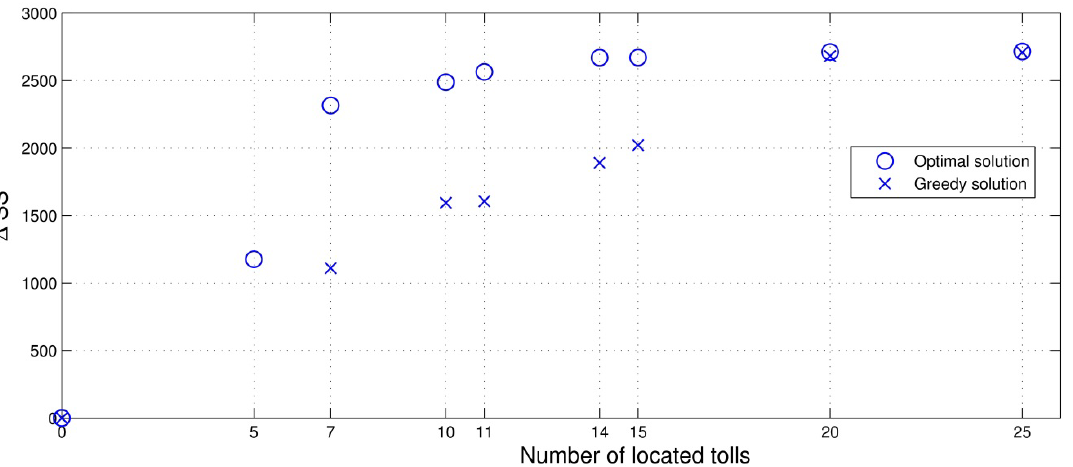
Figure 1. Comparison between optimal and greedy solution of (13), based on the improvement in social